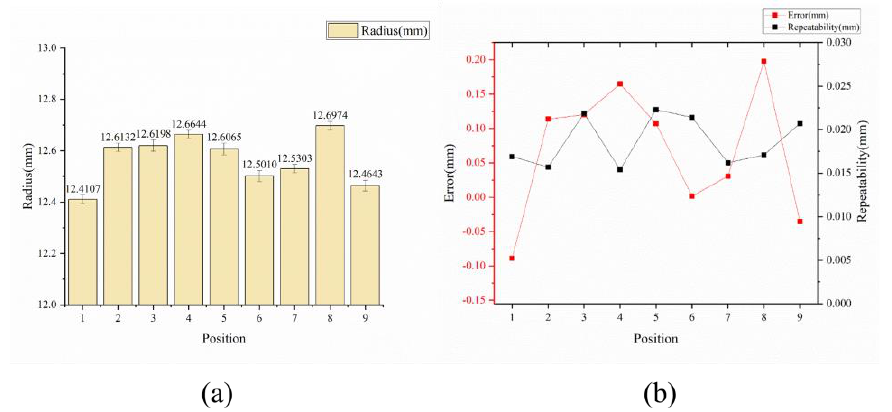
Figure 14. The mean value ( a ), error, and repeatability ( b ) of the radius of the calibration ball meas- ured at different measurement position. measured at different measurement